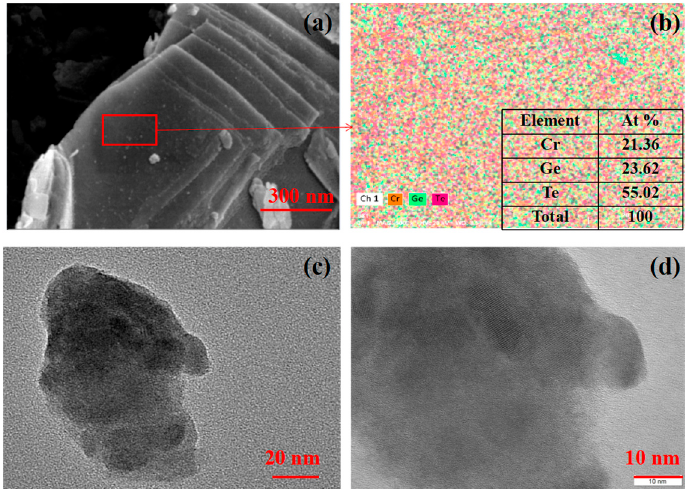
Figure 2. ( a ) The SEM image of the Cr 2 Ge 2 Te 6 nanosheets; ( b ) the corresponding EDX image of the marked area of Figure 2a; ( c ) the TEM image of the Cr 2 Ge 2 Te 6 nanosheets; ( d ) the HRTEM image of the Cr 2 Ge 2 Te 6